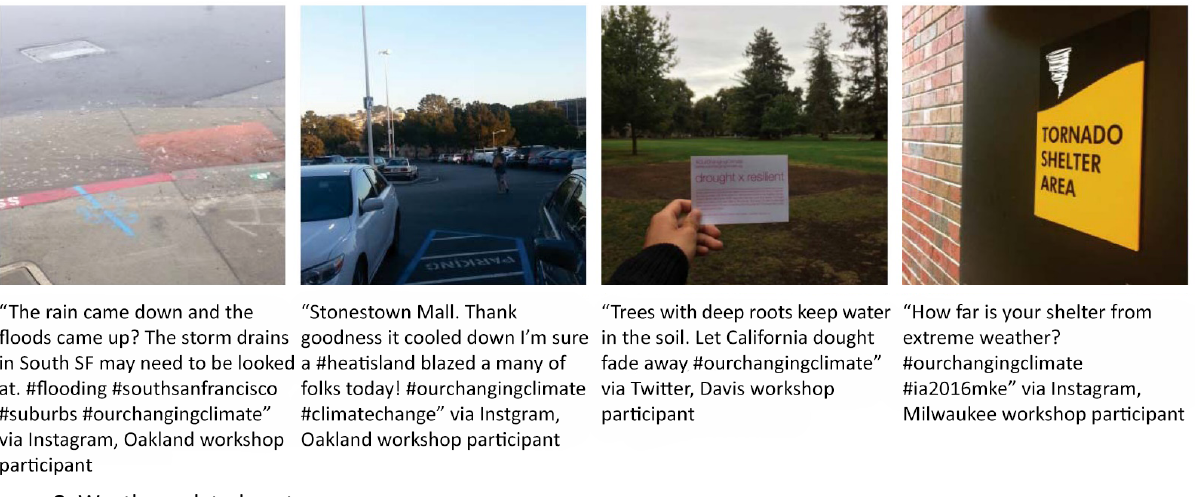
Figure 8. Weather-related posts. Morlot, 2011) and place-based approaches to resilience efforts (Berkes & Folke, 1998; Berkes & Jolly, 2001).